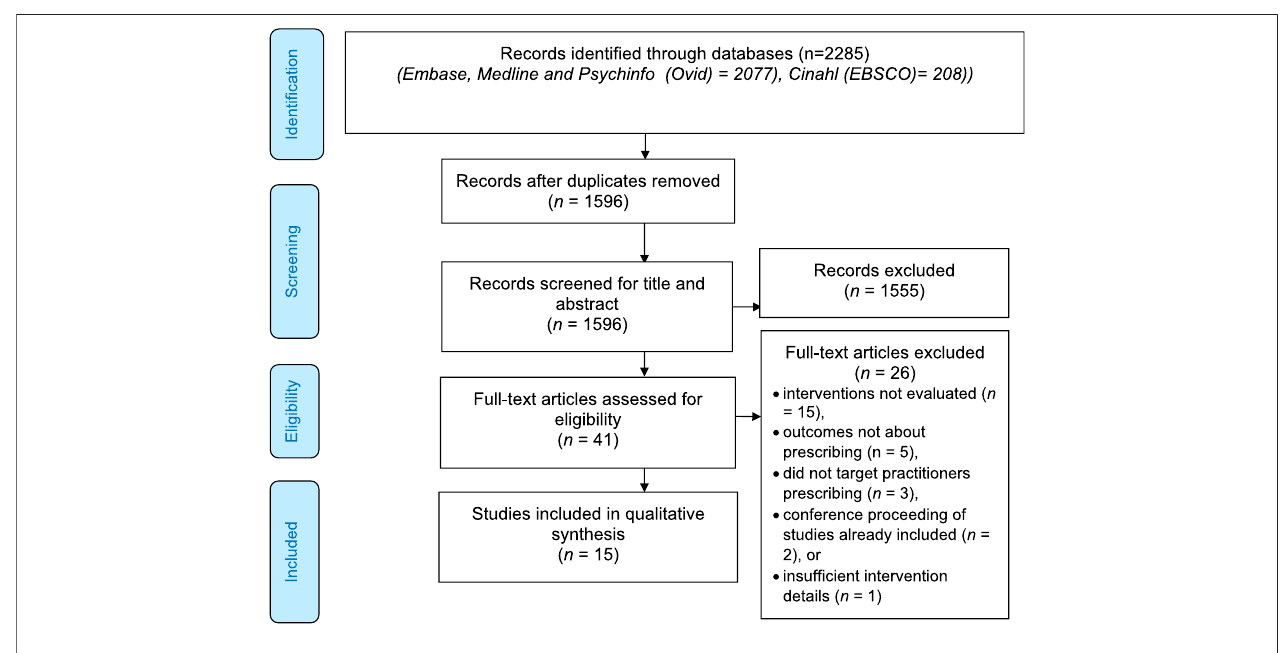
FIGURE 2 | PRISMA fl